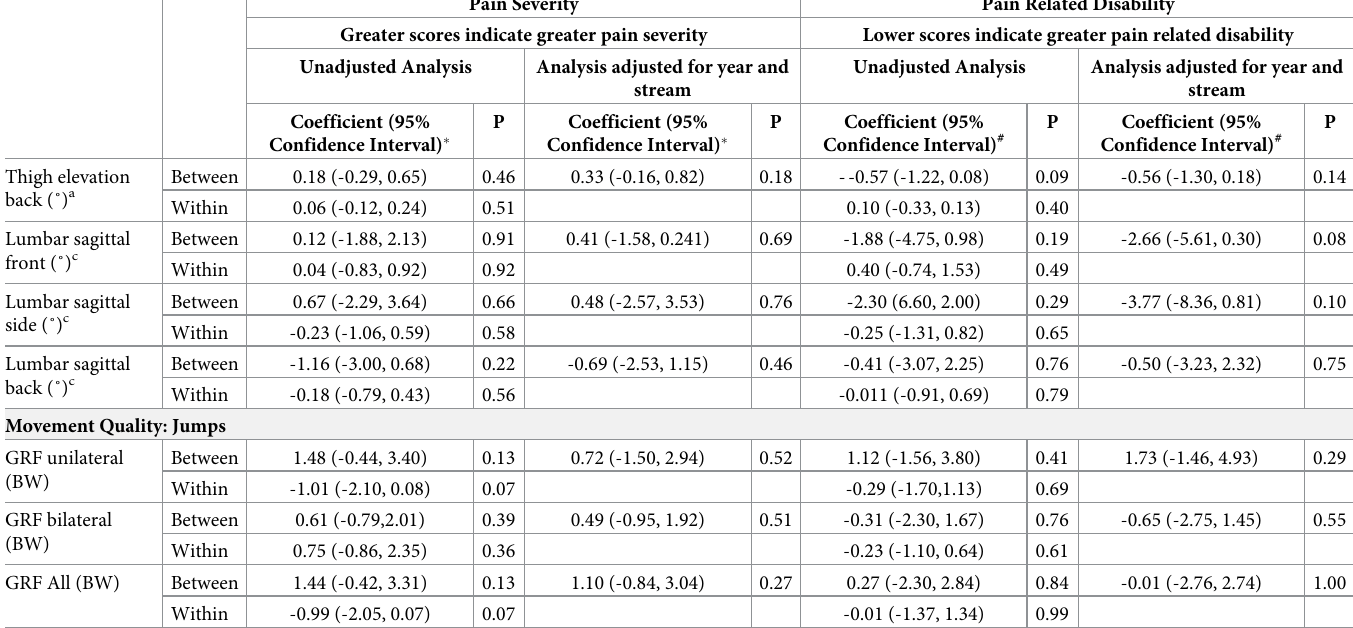
there was no evidence of between-person associations with pain severity after adjusting for year and